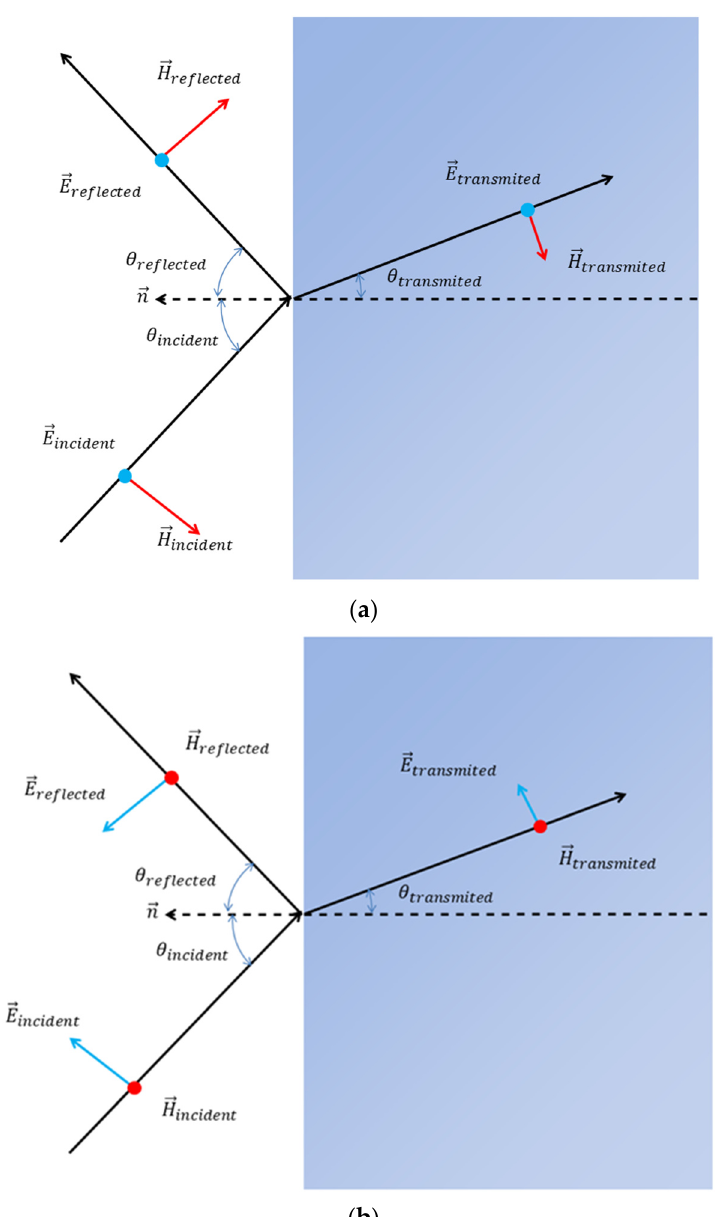
Figure 1. Plane wave incident on a planar boundary: ( a ) with electric field perpendicular to the incidence plane; ( b ) with electric field parallel to the incidence plane.